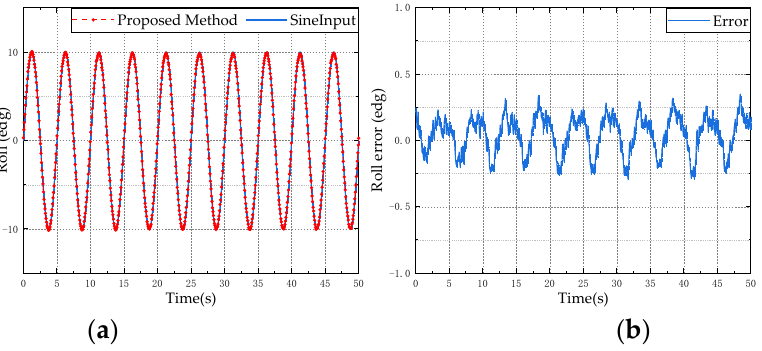
Figure 7. Roll angle simulation test results: ( a ) is the estimation result of the proposed method; ( b ) is the error between the estimated value and the reference value.